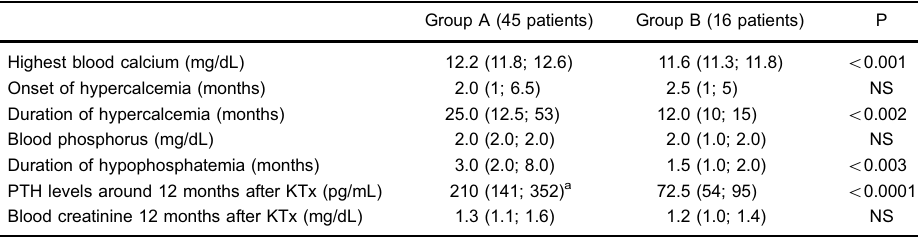
Table 1. Blood calcium, phosphorus, parathyroid hormone (PTH), and blood creatinine data from patients with hypercalcemia after kidney transplantation (KTx) (groups A and B). Group A (45